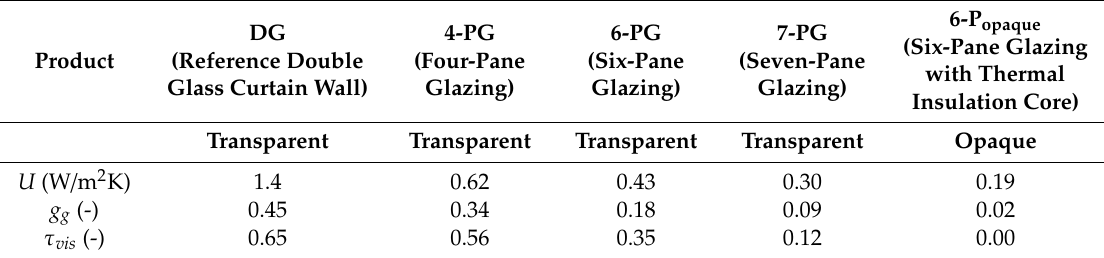
Table 1. Thermal and radiative properties of advance glazed facade structures